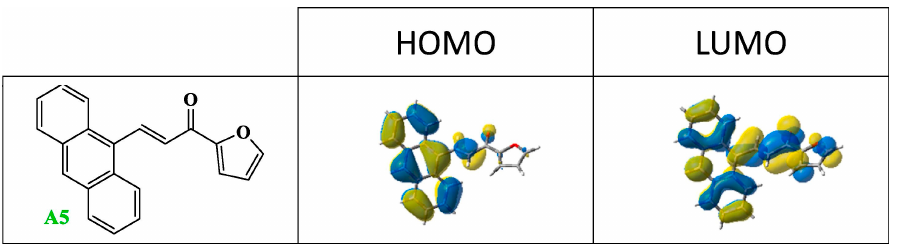
Figure 17. Contour plots of the HOMO and LUMO energy levels of A5. Reproduced with permission of Ref. [148] . Table 5. Optical characteristics of A1–A7 in acetonitrile. Data extracted from Ref. [148] .